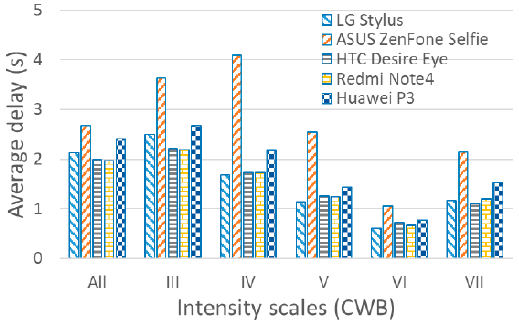
Figure 5. The average delay of lead time using different smartphones with 3 s prediction model for the earthquakes of intensity scales III to VII. The average delay of lead time of all the earthquakes is also shown (All).